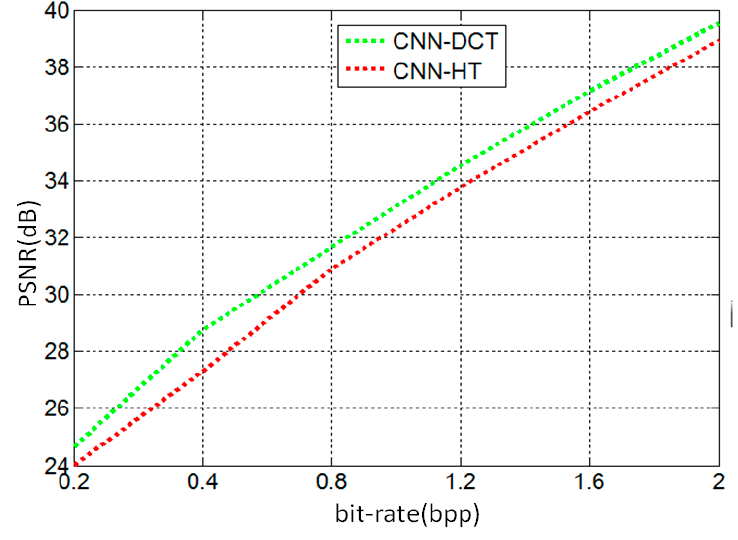
Figure 11. Comparison of compression performance using the different learning networks.